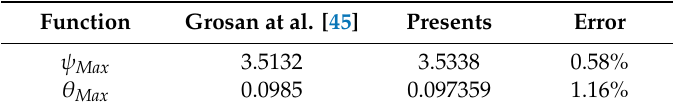
Figure 3. Comparison of the ( a ) streamlines and ( b ) isotherms contours between the present results (left) and Hatami [33] (right). Table 2. Comparisons of the maximum values of the stream function and isotherms at 𝑅𝑎 = 10 (cid:2871) , 𝜙 (cid:3002)(cid:3039) = 𝜙 (cid:3004)(cid:3048) = 0%, 𝐷 (cid:3046) = 0, 𝛼 (cid:3046) = 0. (cid:3118) (cid:3016) (cid:3119) Function Grosan at al. [45]